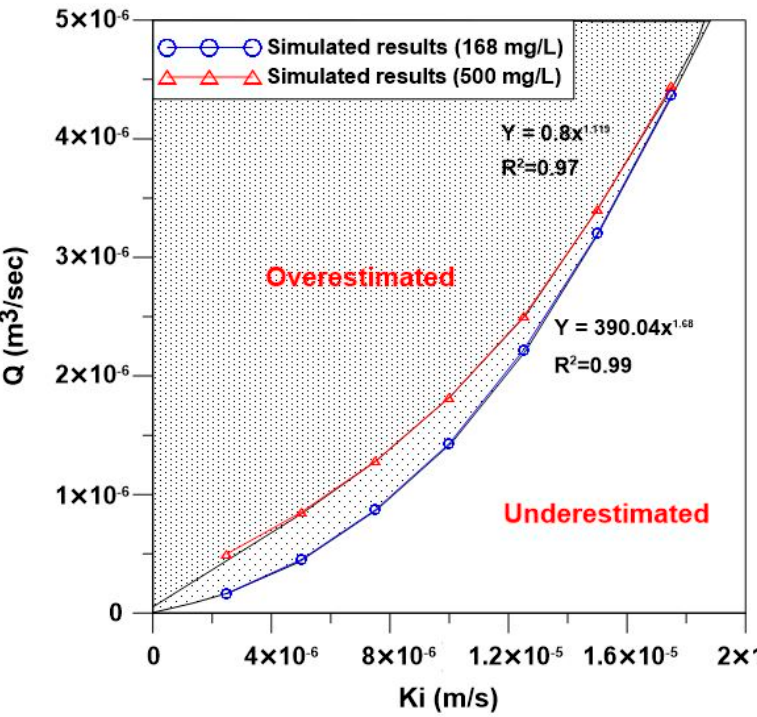
Figure 8. The obtained reasonable pumping rates under various background groundwater velocity conditions for two concentration cases: 168 mg/L (triangles) and 500 mg/L (circles).